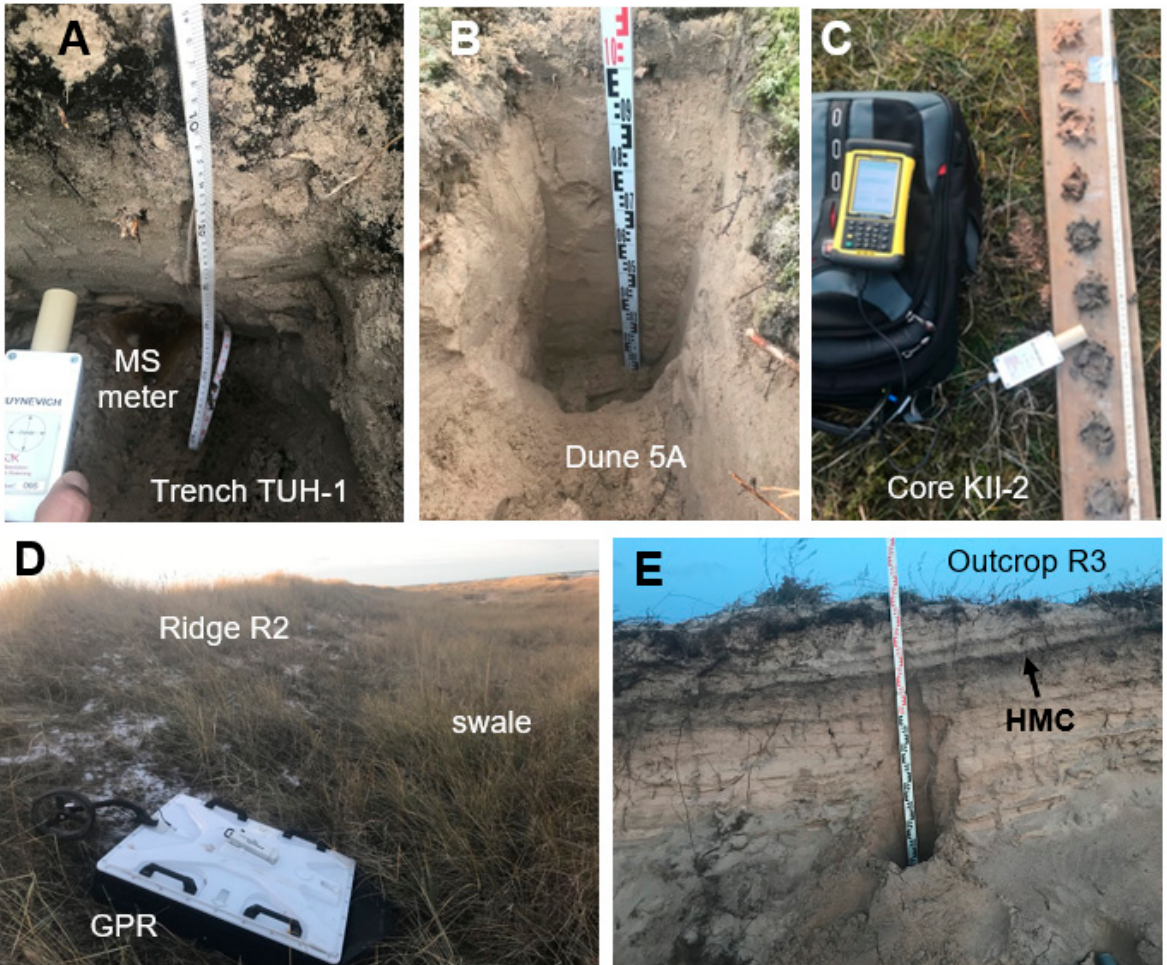
Figure 2. Field photographs of sampled sites on Hiiumaa ( A , B ) and Saaremaa ( C – E ) Islands (see Figure 1B,C for locations). ( A ) A trench through a beach ridge shows well-sorted quartz-rich sand down to a water table at 0.7 m. A Bartington MS2K field sensor was used for in situ magnetic susceptibility (MS) measurements. Core TUH-2 was taken landward of the trench. ( B ) A 1 m deep trench through the top of a high parabolic dune seaward of TUH sites. ( C ) Samples from a 2.4 m deep core KII-2 (ridge R2) at the Harilaid strandplain arranged on a wooden board showing darker, less oxidized sand with depth (toward the bottom of the photo). The personal digital assistant (PDA) and MS sensor are visible, with MS3 m in the backpack. ( D ) Ridge 2 and a seaward swale (R2/R3), with a ground-penetrating radar (GPR) antenna (~1 m long) for scale. ( E ) An erosional scarp reveals the bedding of the upper beach and dune section of ridge R3. Thin paleosol horizons and multiple